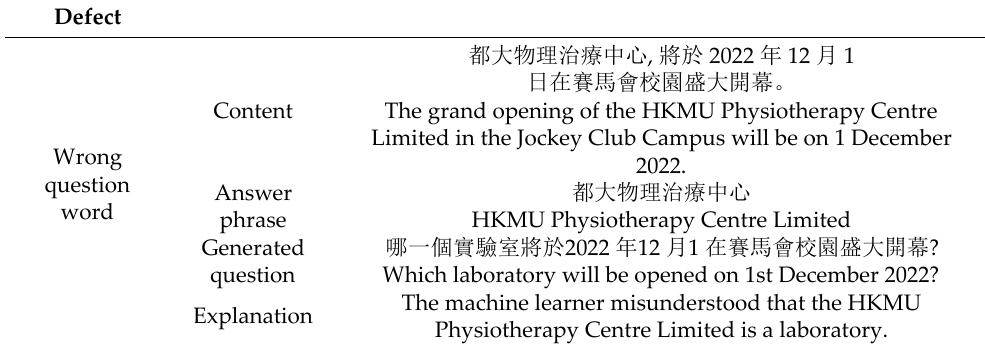
Table 4. Result of some generated